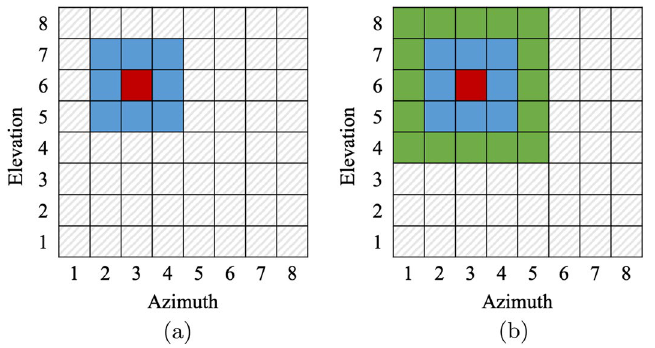
Fig. 7 Examples of candidate beams for Local Search 1 and Local Search 2, respectively. a Local Search 1. b Local Search